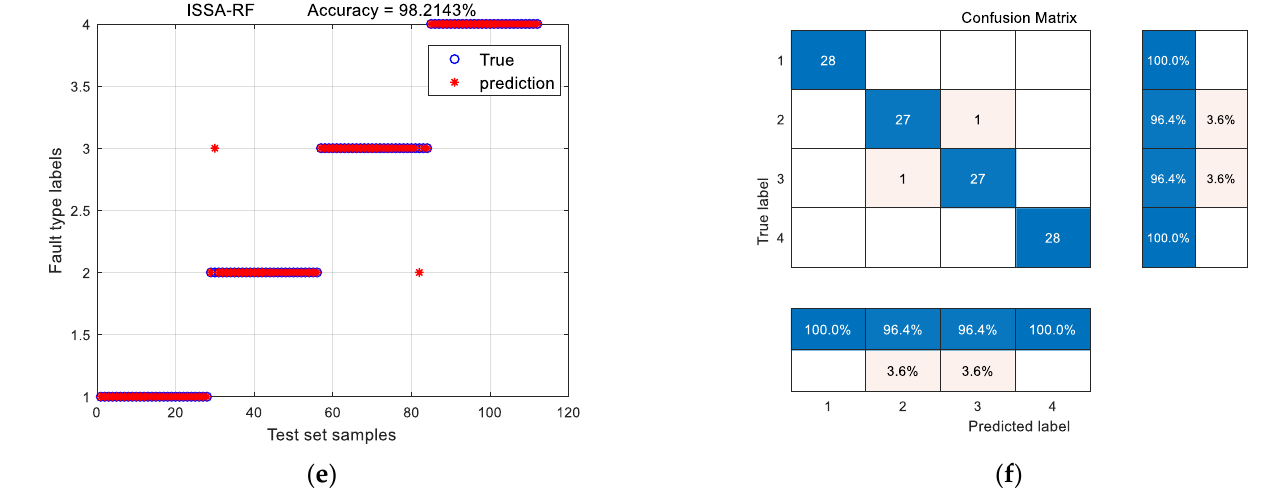
Figure 10. Actual and predicted classification results of each algorithm. ( a ) BP; ( b ) SVM; ( c ) RF; ( d ) SSA-RF; ( e ) ISSA-RF; ( f ) ISSA-RF confusion.